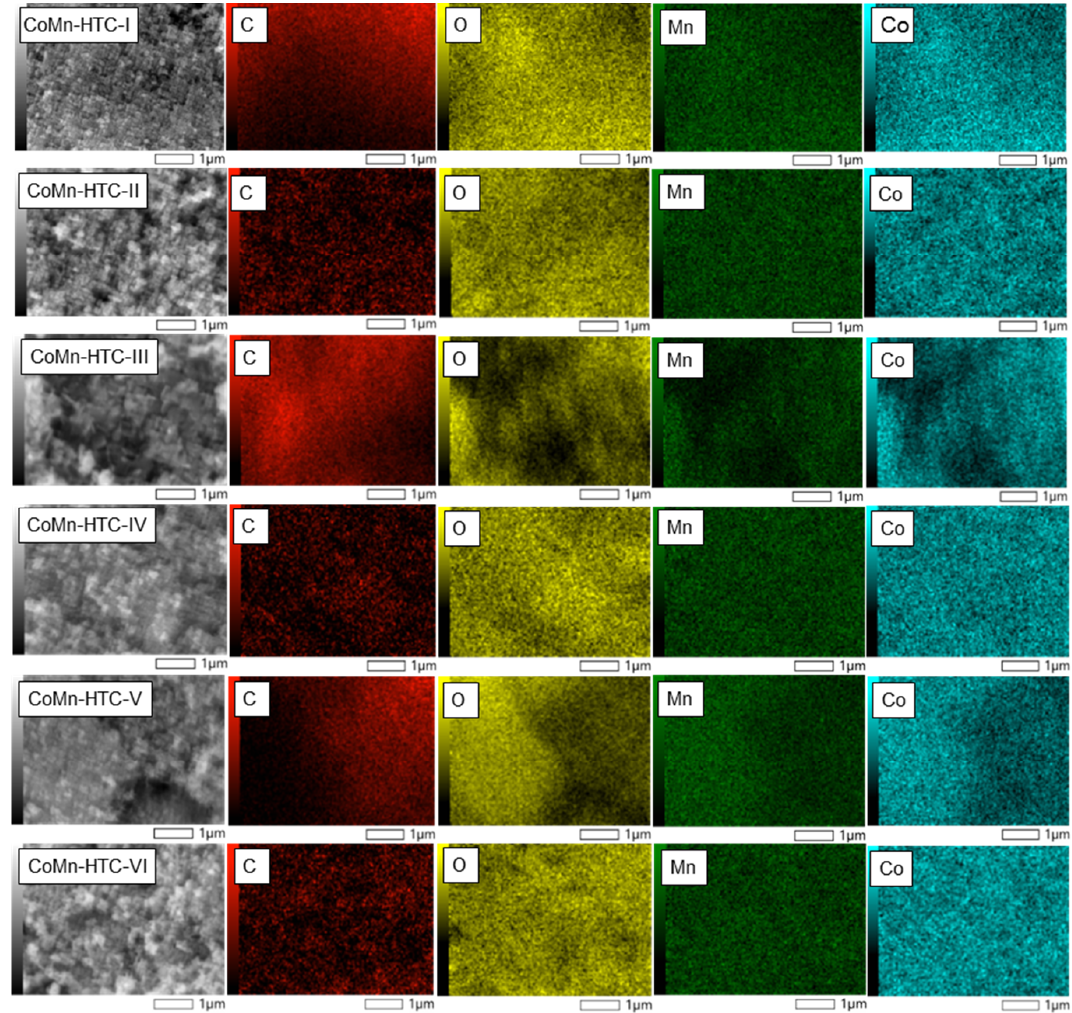
Figure 7. Energy-dispersive X-ray spectroscopy (EDX) mapping of the CoMn-HTC catalysts.